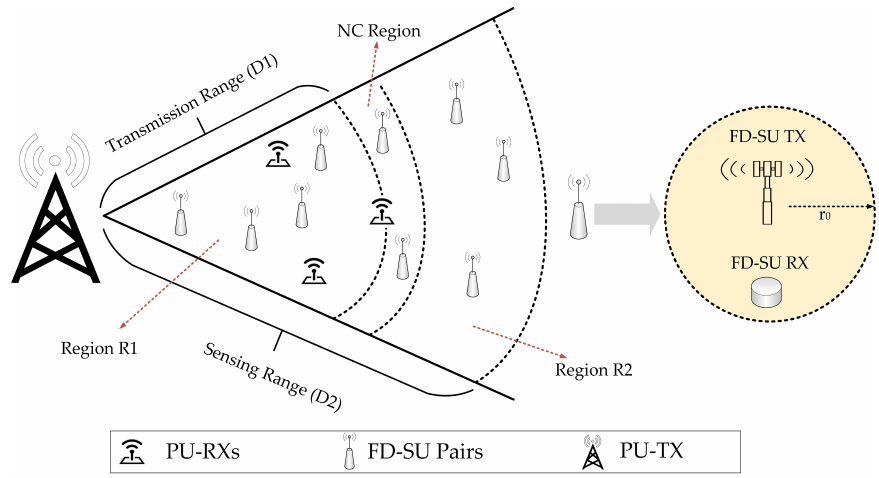
Figure 4. Cognitive radio (CR)-Internet of Things (IoT) spectrum-heterogeneous